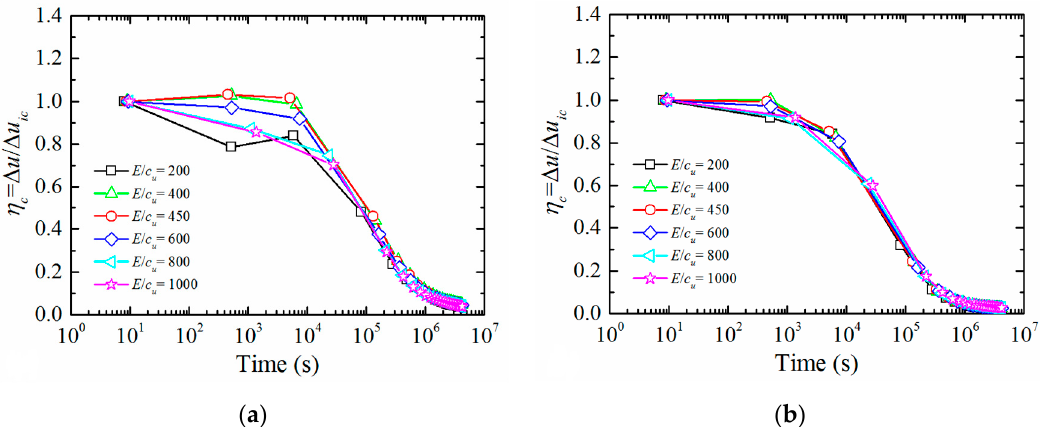
Figure 15. Normalized EPWP dissipation curves after installation under various soil elastic moduli. ( a ) At depth of 4.9 m; ( b ) at depth of 7.5 m.